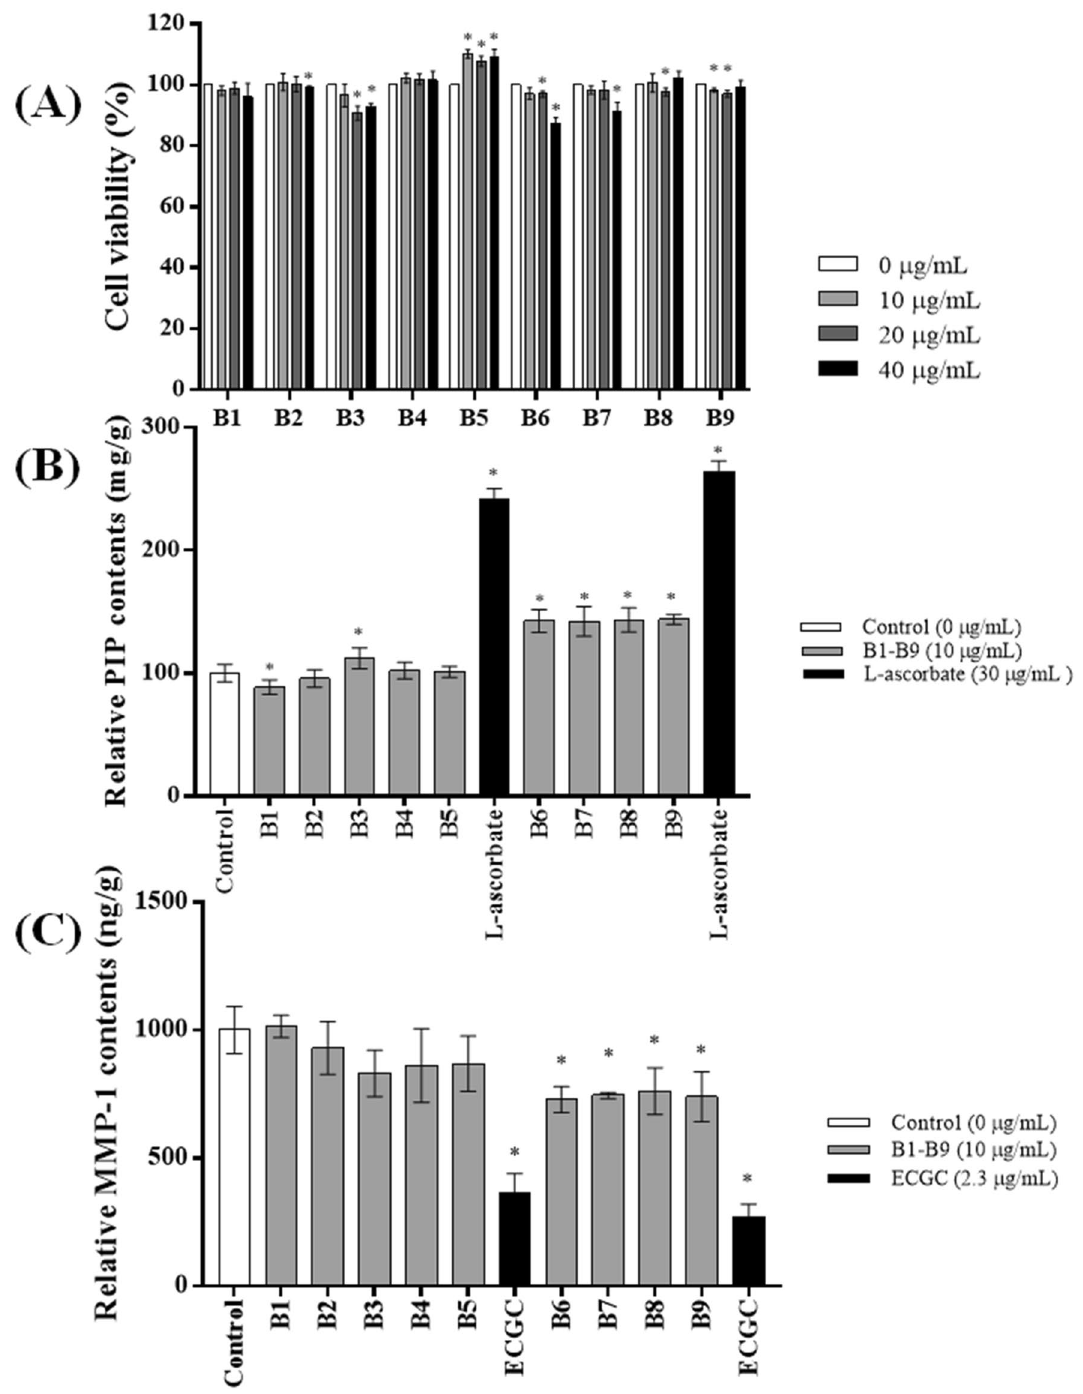
Figure 1. Cell viability and anti-wrinkle activity of GBEs. ( A ) Cell viability of human dermal fibroblasts (HDFs) treated with DW-GBEs (B2–B5) and MRW-GBEs (B6–B9) at different concentration. The data are expressed as % of vehicle control (Mean ± SD, * p < 0.05, Vehicle control vs. Sample extracts). ( B ) Relative PIP contents 1 in human dermal fibroblasts (HDFs) after treated with different samples at the concentration of 10 µm/mL. The data are expressed as mg/g when vehicle control is set to 100 mg/g (Mean ± SD, * p < 0.05, Vehicle control vs. Sample extracts vs. Positive control 2 ). 1 Relative PIP contents: the relative PIP contents in HDFs cells after treatment when the relative PIP content of vehicle control is set to 100 mg/g. 2 Positive control: l-ascorbate. ( C ) Relative MMP-1 contents 1 in human dermal fibroblasts (HDFs) treated with GBEs samples at 10 µm/mL. The data are expressed as ng/g when vehicle control is set to 1000 ng/g (Mean ± SD, * p < 0.05, Vehicle control vs. Sample extracts vs. Positive control 2 ). 1 Relative MMP-1 contents: The relative MMP-1 contents in HDFs cells after treatment when the relative MMP-1 content of vehicle control is set to 1000 ng/g. 2 Positive control: epigallocatechin gallate (ECGC). All the charts were drawn by Prism Software